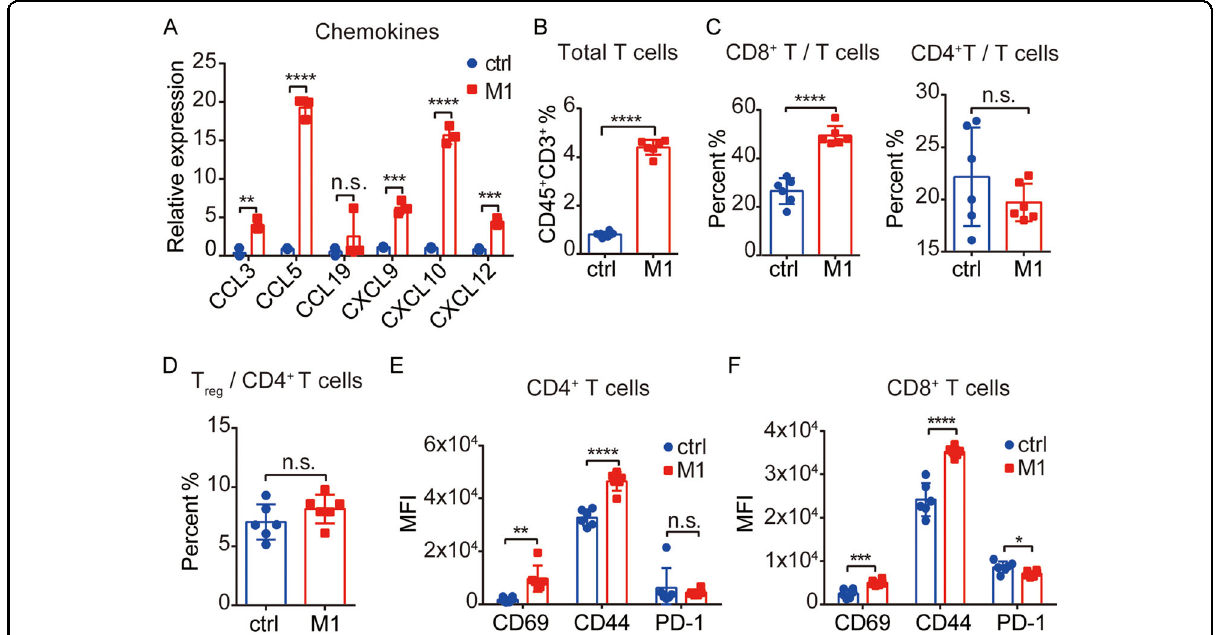
Fig. 4 M1 acts as an immunostimulatory agent and induces T-cell recruitment and activation in tumor microenvironment (TME). A C57BL/6 mice were implanted subcutaneously in the right fl ank with B16F10 cells on day 0 and treated intravenously with ctrl ( n = 3) or M1 ( n = 3) (1 × 10 7 pfu) once per day on days 6 – 8. The tumors were harvested on day 9, the total RNA was isolated, and qRT-PCR was performed to detect the expression of chemokines. The P value was determined by a two-tailed Student ’ s t test. B – D C57BL/6 mice were implanted subcutaneously in the right fl ank with B16F10 cells on day 0 and treated intravenously with ctrl ( n = 6) or M1 ( n = 6) (1 × 10 7 pfu) once per day on days 6 – 10. The tumors were harvested on day 13 and analyzed by fl ow cytometry to assess intratumoral T cells ( B ), the percentages of CD8 + and CD4 + T cells in the total T- cell population ( C ) and T reg in the CD4 + T-cell population ( D ). The P value was determined by a two-tailed Student ’ s t test. E , F the expression of CD69, CD44, and PD-1 on CD4 + T cells ( E ) and CD8 + T cells (F) gated from B to D was detected by fl ow cytometry. The P value was determined by